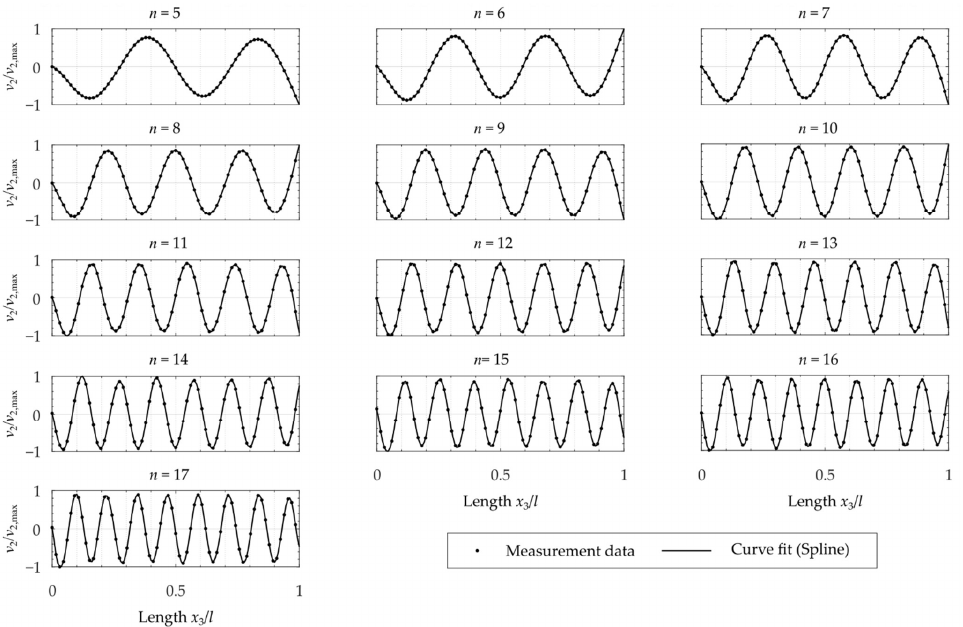
Figure 7. Measured velocity distribution 𝑣 (cid:2870) (𝑡̅) at the time of maximum displacement of excitation 𝑢 (cid:2870), e (𝑡̅) = u(cid:3548) (cid:2870), e for a harmonic mono-frequency excitation at the determined resonance frequencies 𝑓 e = 𝑓 (cid:3041) with 𝑛 = 5,6,…,17 (tightening torque 𝑀 t = 1.1 Nm, voltage amplitude of the actuator 𝑈(cid:3553) e = 11 V).